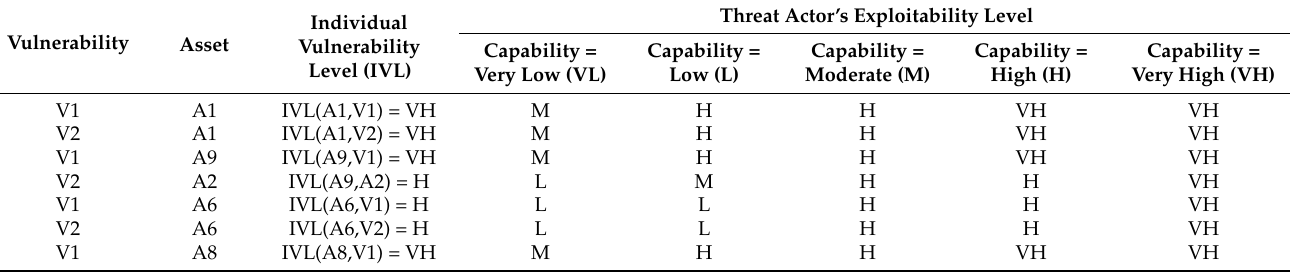
Table 7. Individual vulnerability exploitation.